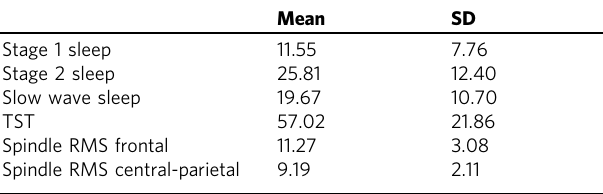
Table 1 Sleep characteristics of the post-encoding nap.